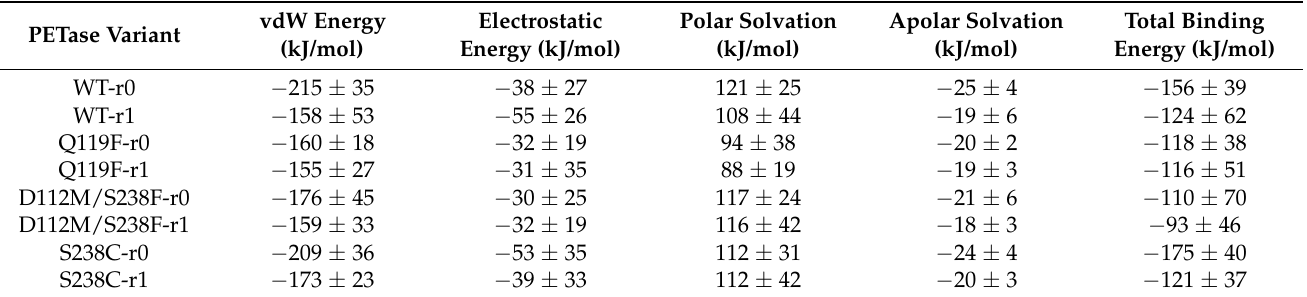
Table 1. MM/PBSA binding free energy of each